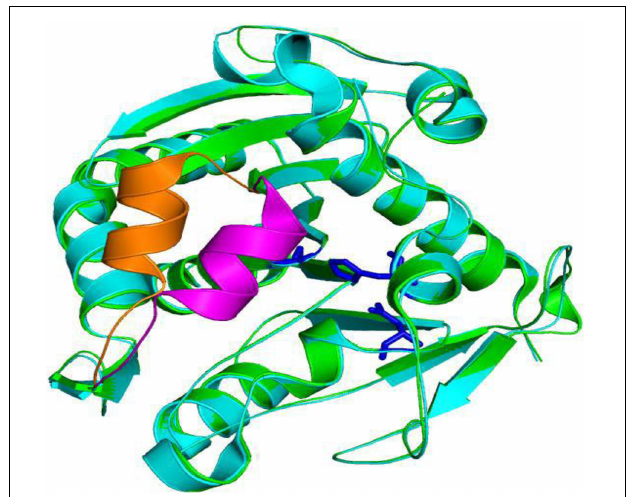
FIGURE 3 | Schematic diagram of superimposition of opening and closing of lipase lid structure of Thermomyces lanuginosus. The close lid, open lid, and catalytic triads were highlighted by magenta, orange, and blue colors, respectively (Khan et al.,